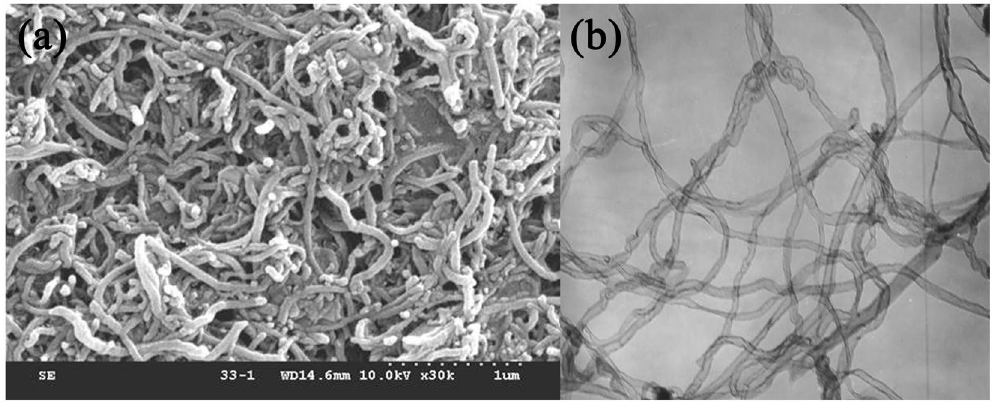
Figure 1. Morphology of the CNT samples heat-treated at 700 °C: ( a ) SEM image and ( b ) TEM